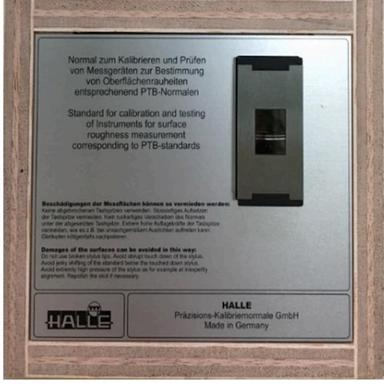
Photograph of the depth-setting standard artefact provided by PTB.